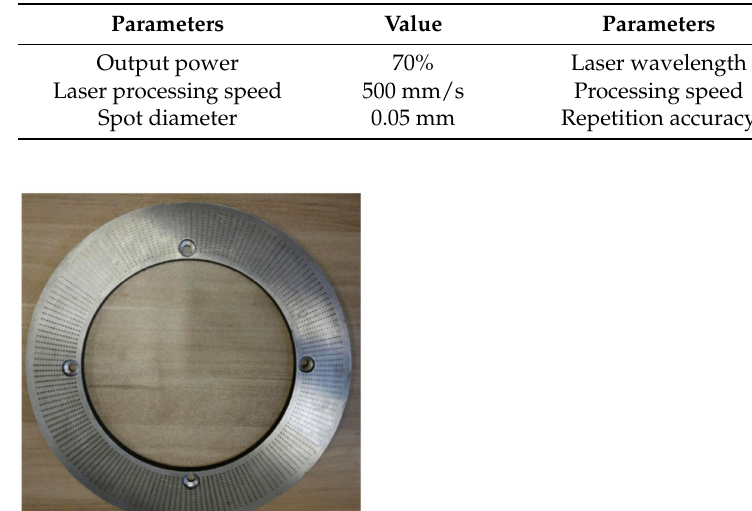
Table 4. Laser processing parameters.